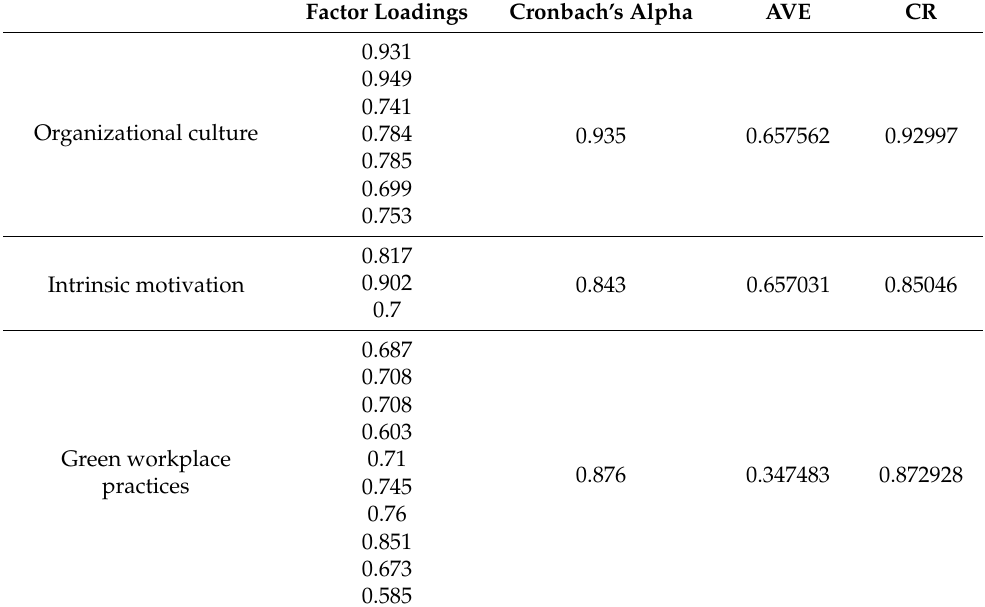
Table 2. Evaluation of the measurement model.